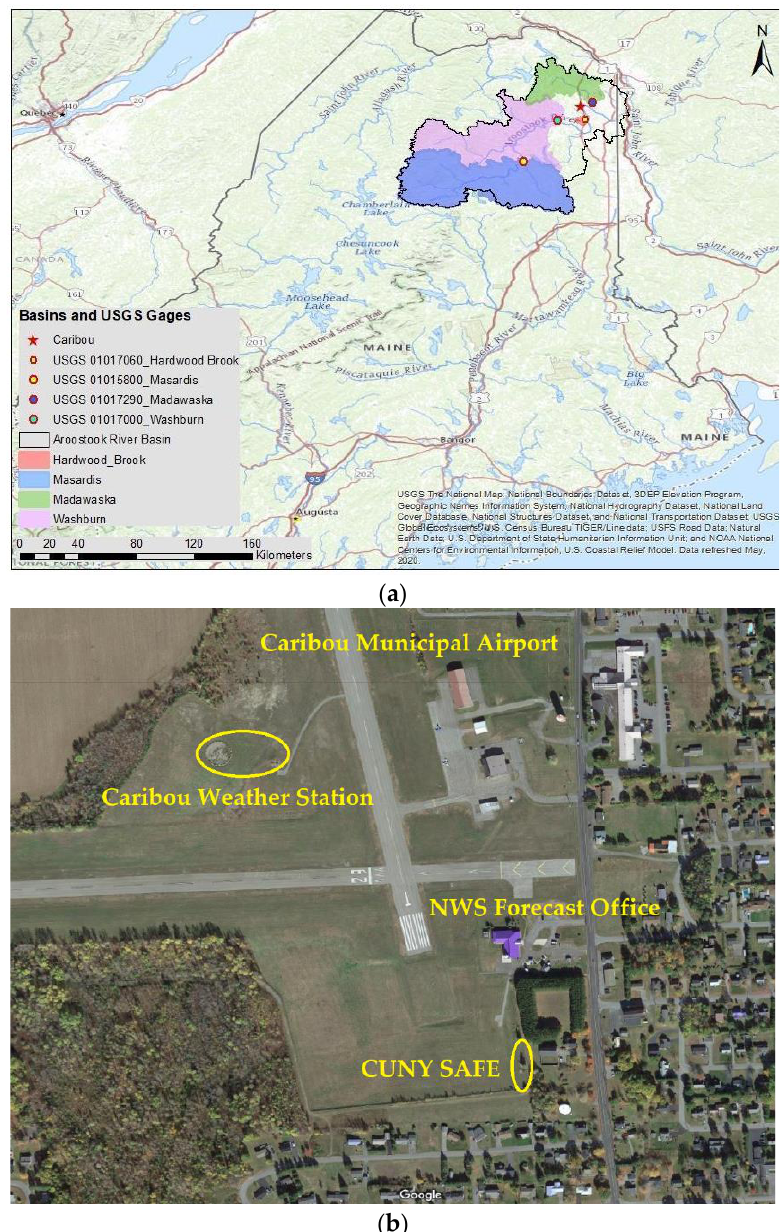
Figure 1. ( a ). Locations of the basin, sub-basins, and gaging stations used in this study. ( b ). Location of the CUNY-SAFE and NWS weather stations.